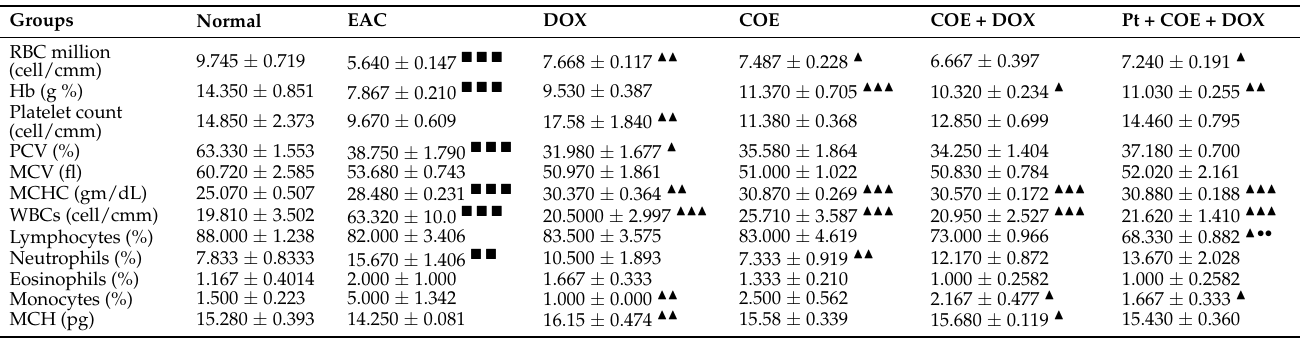
Table 2. Effect of COE on haematological parameters.